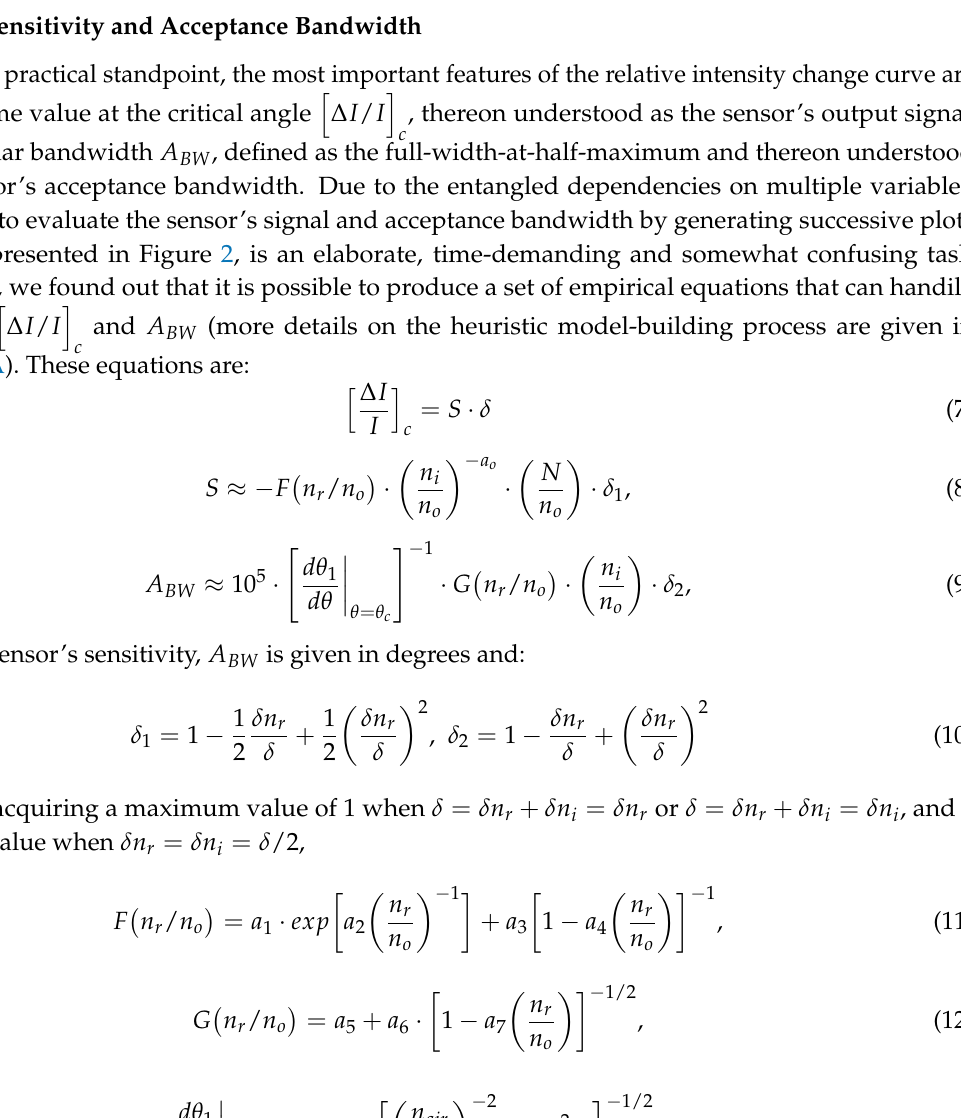
Figure 2. Transmittance T p (solid line) and relative intensity change ∆ I / I for δ = δ n r = 1 µ RIU (dashed line) and δ = δ n i = 1 µ RIU (dotted line), versus incidence angle θ . Calculations assume n r / n 0 = 0.75, n i / n 0 = 10 − 5 , N = 12, α = 76.1 ◦ , n o = 2.16, n air =